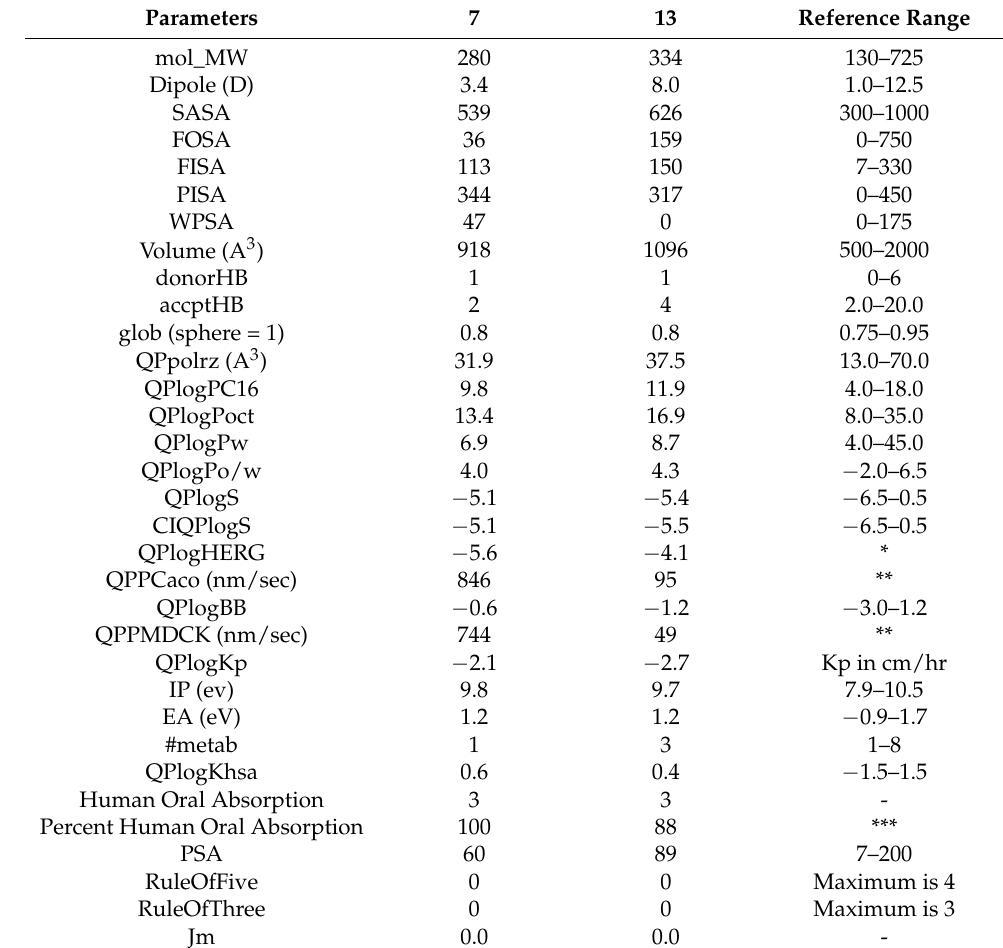
Table 5. ADME properties of compounds of compounds 7 and 13